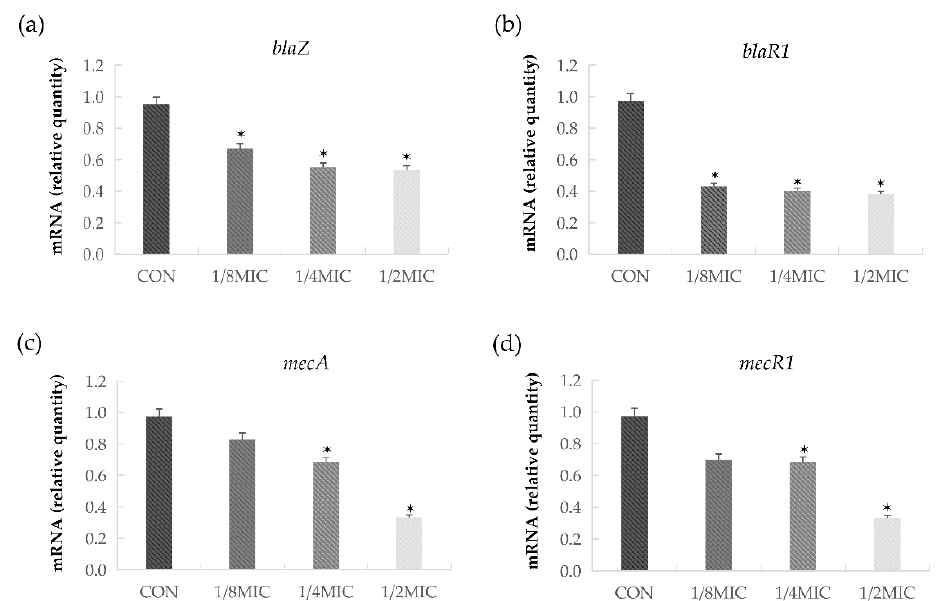
Figure 4. The relative gene expressions of blaR1, blaZ, mecA, and mecR1 in S. aureus after growth at sub-concentrations of BDMC. The relative gene expressions of ( a ) blaR1; ( b ) blaZ; ( c ) mecA; ( d ) mecR1 were reduced in a dose-dependent manner. The data were presented as the mean ± standard deviation of the three independent experiments. * represents p < 0.05. CON, untreated control MRSA.